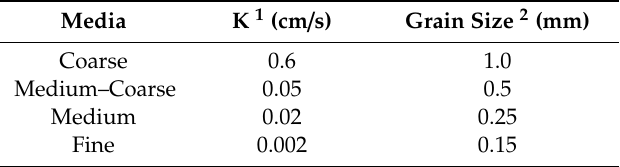
Table 2. Selected hydraulic conductivity (K) and grain size values per media type chosen from physical experiments.